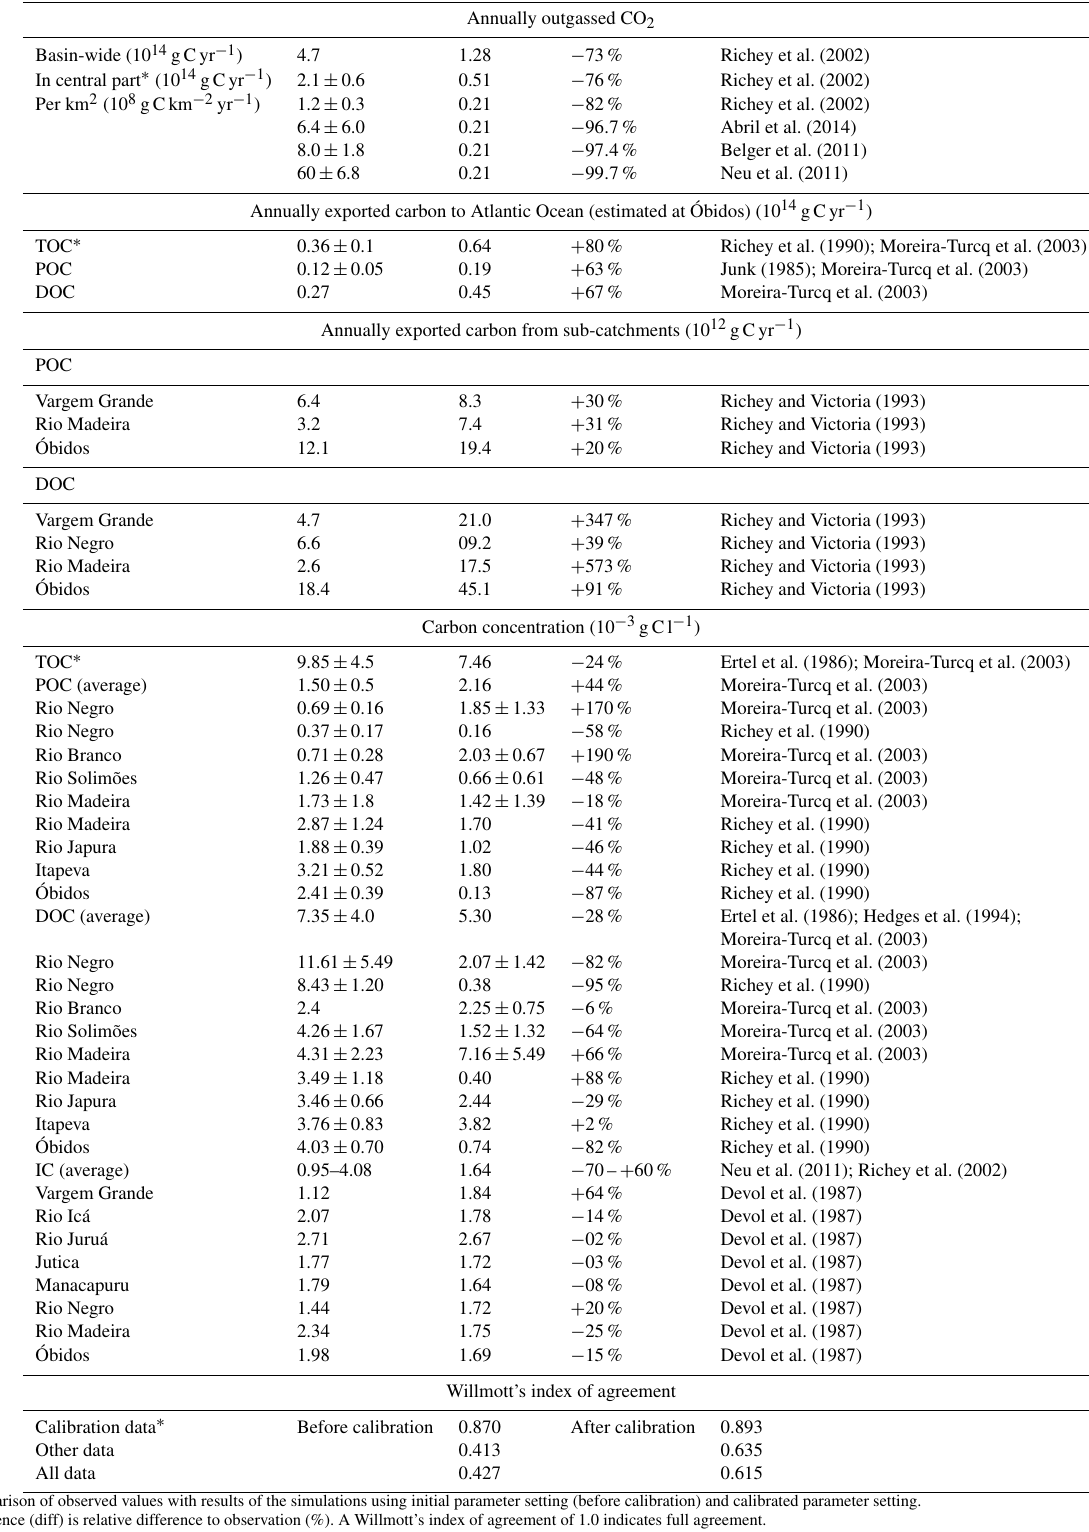
Table 4. List of data used for calibration and validation. Observation Simulated Diff Source Annually outgassed CO 2 Basin-wide (10 14 gCyr − 1